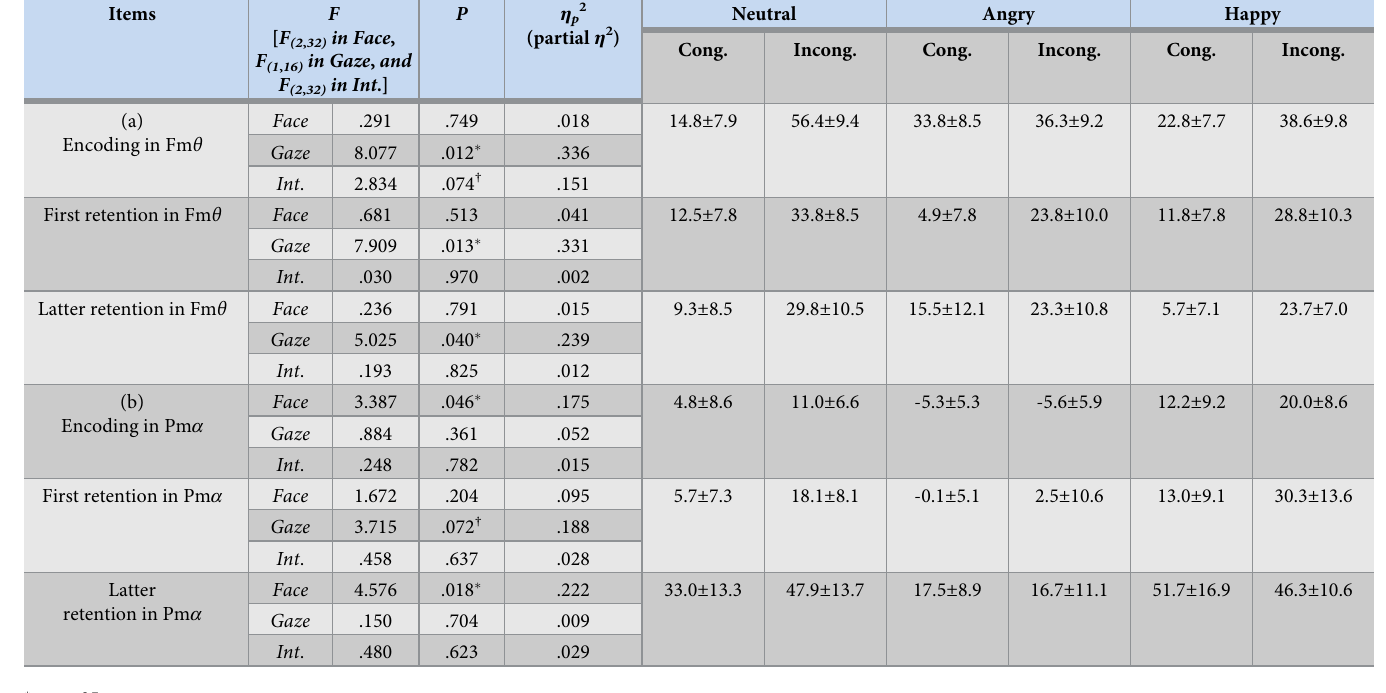
Fig 4 ( lower section ) indicates the mean values ( ± SEM) and significance of the (c) Fm θ and (d) Pm α powers in each period for young adults (S5 File). For the Fm θ during the first reten- tion period, the ANOVA (Table 5) revealed main effects of Face ( p = .064 † ) and Gaze ( p = .025) and an interaction between the two factors ( p = .026). In the multiple comparisons for Face, the Fm θ power was higher in happy faces than for neutral faces ( ^ p = .025). Simple main effects were found for the Gaze condition (i.e., a congruency effect) in happy faces ( p = .015) and for Face under the incongruent gaze condition ( p = .003). The multiple comparisons showed a greater value for happy faces than for neutral ( ^ p = .008) or angry ( ^ p = .076 † ) faces under the incongruent condition. For the Pm α during the first retention period, there was a tendency for a main effect of Face ( p = .086 † ), as a result of the ANOVA. Detailed information on the tests performed after the ANOVA is indicated in Supplementary S6 Table. 3.1.3 Recognition of facial expressions. \At the end of the EEG experiment, all partici- pants were asked to respond verbally to identify the emotional category (i.e., neutral, angry, and happy) of the faces presented during the experiment to confirm whether they could accu- rately recognize the emotions. The accuracy was almost 100%: three errors in children (two cases mistaking a neutral face for an angry face and one case mistaking a happy face for a neu- tral face) and three errors in adults (three cases mistaking a neutral face for an angry face).